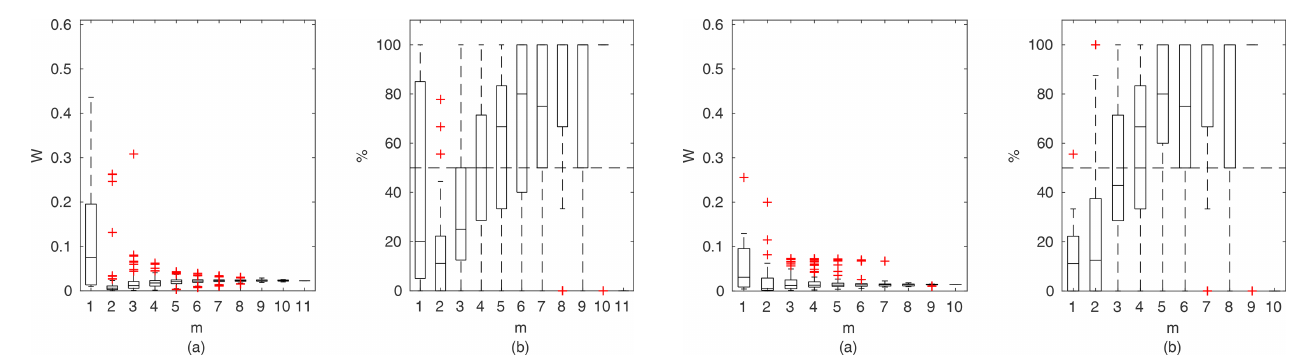
Figure 6. GTLM results for the Ritobacken case study, spring 2012: (a) averaged relative confidence widths W as a function of observa- tion set size m used for model identification; (b) percentage of veri- fication points enclosed by the confidence intervals (100% denotes all points within intervals, box spans over the 25% and 75% quan- tiles, the median is given with horizontal line, whiskers indicate the result extent, and cross marks are for extreme values).